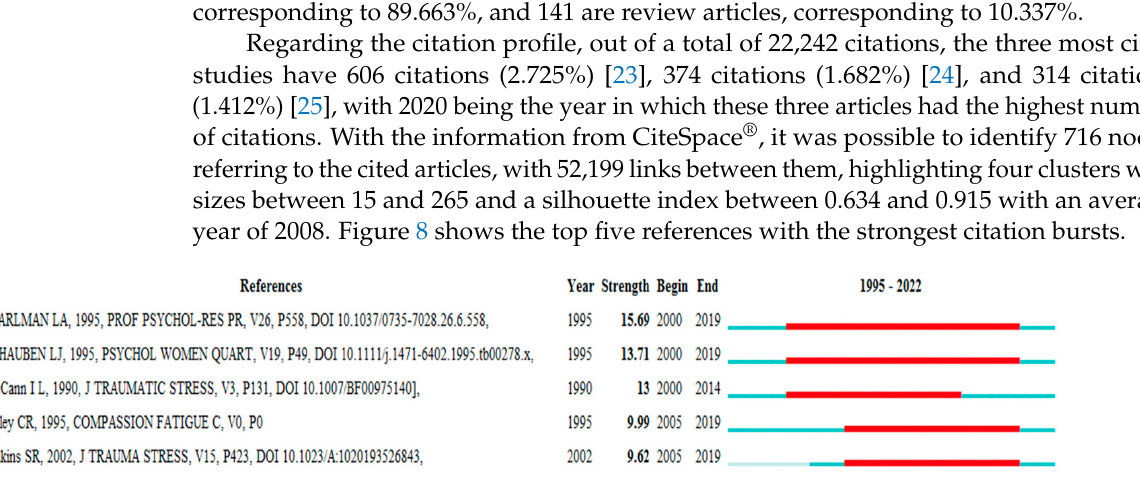
Figure 8. Top 5 references with the strongest citation bursts.